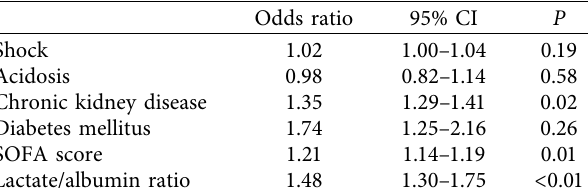
Table 4: Multivariable logistic